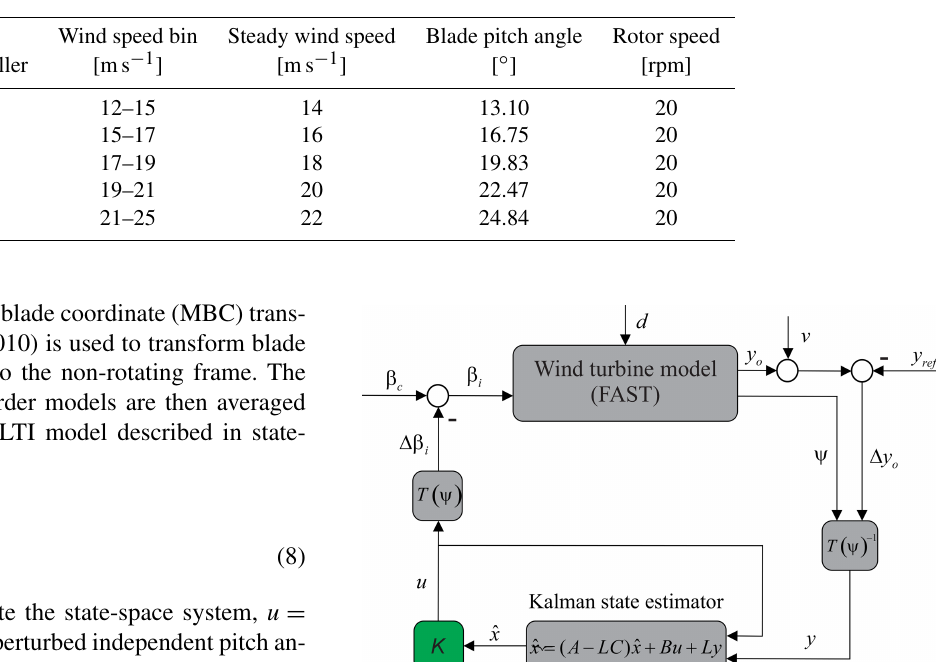
Table 2. Design operating points for the IPC controllers.